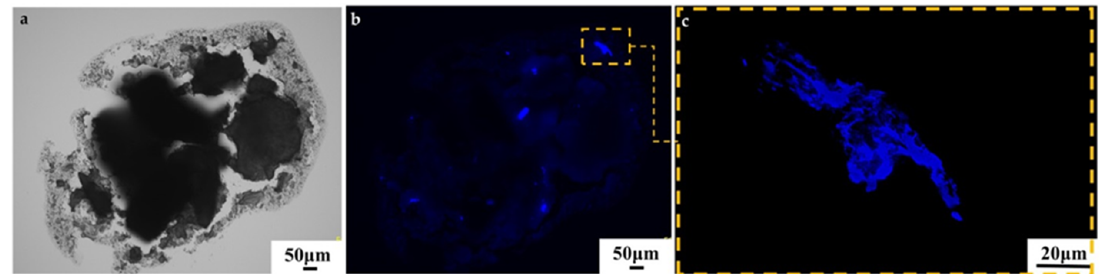
Figure 19. ( a ) Light microscopy and ( b ) fluorescence microscopy images of demineralized fragment of the central filamentous core of sample Jal 11 after Calcofluor White (CFW) staining (light exposure time 1/8 s.). The sample contains micro-fragments showing strong fluorescence ( b , c ) typical of chitin remnants.